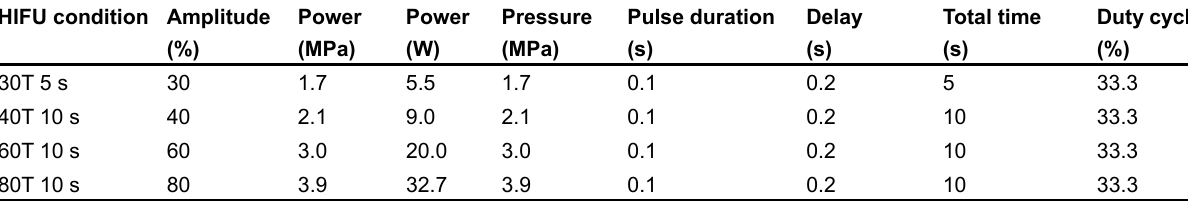
Table 2 . HIFU parameters for HIFU treated CT26 cells in vitro HIFU condition